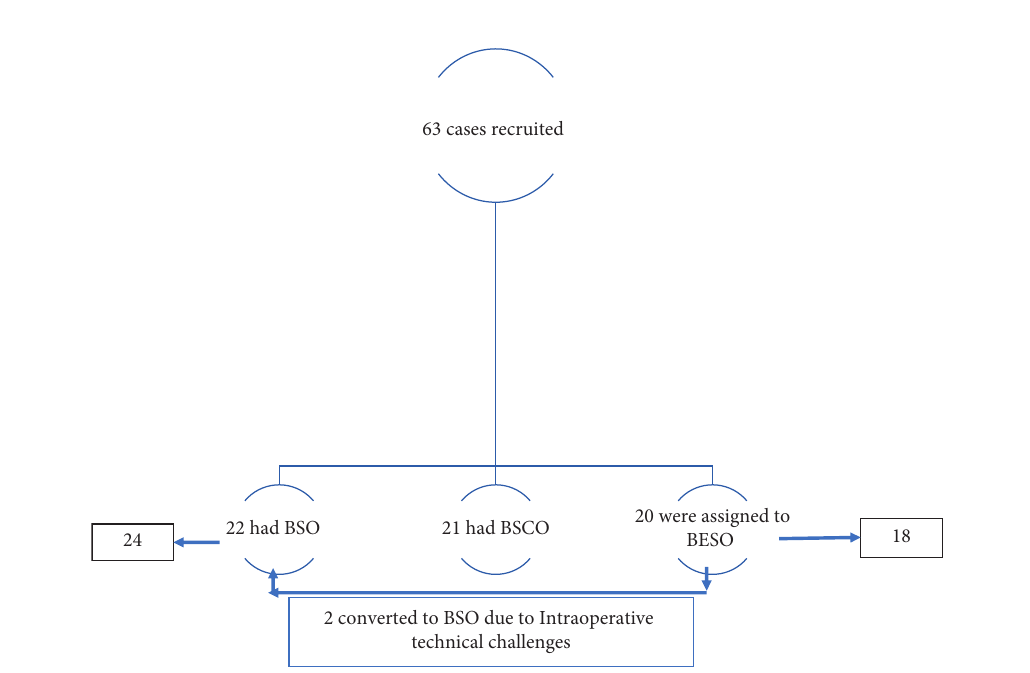
Figure 4: Schema of patient recruitment. Table 2: Sociodemographic characteristics of subject participants.